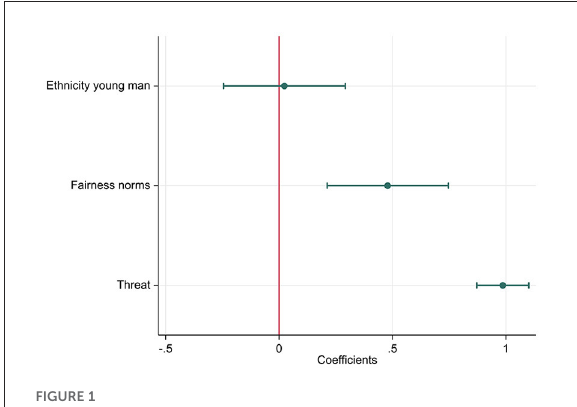
FIGURE1 Factorial survey treatment-effects on the likelihood of the old white man calling the police, multilevel mixed-effects linear